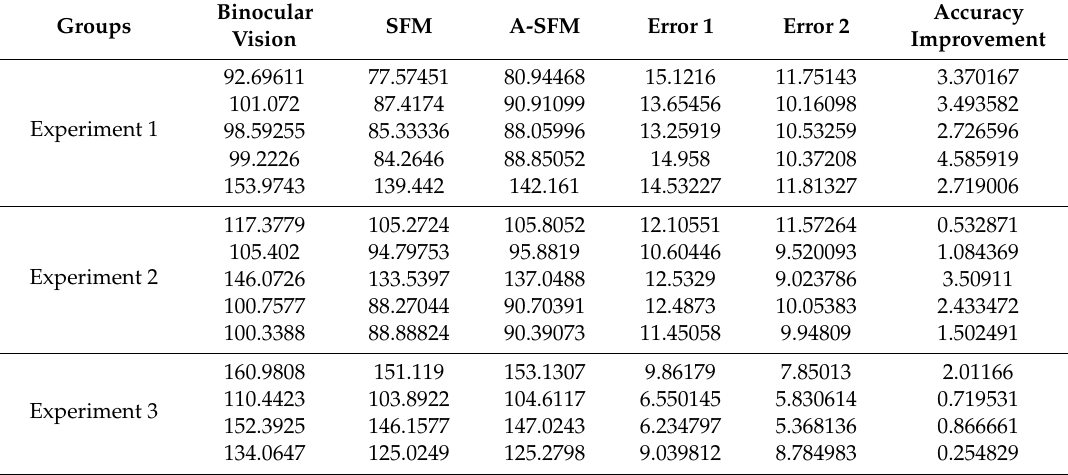
Table 10. Results of comparing the two reconstructions with the binocular vision measurements.